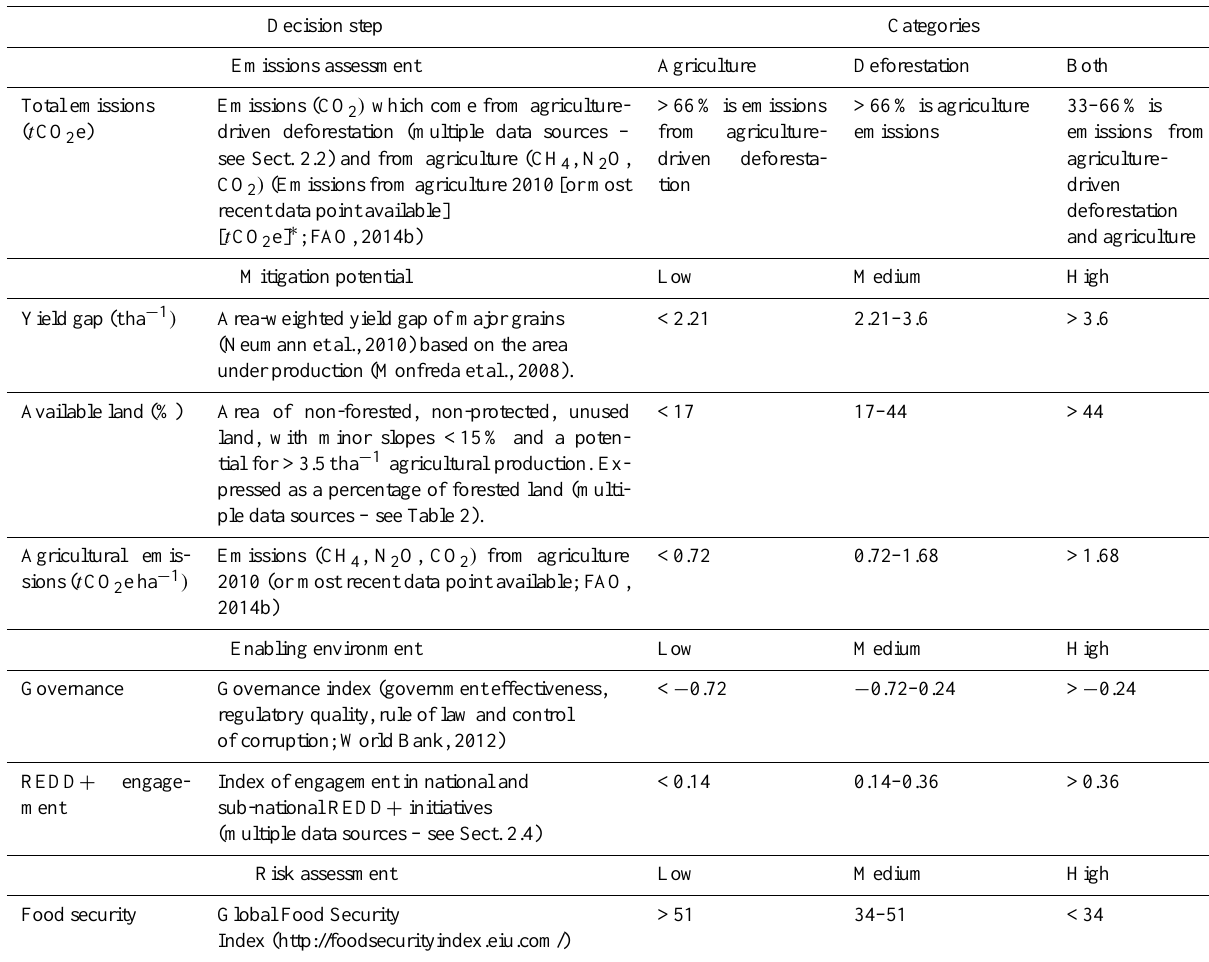
Table 1. Data sources for the identification of target countries for mitigation interventions. Categories are selected by thresholds at the 1 / 3rd and 2 / 3rd